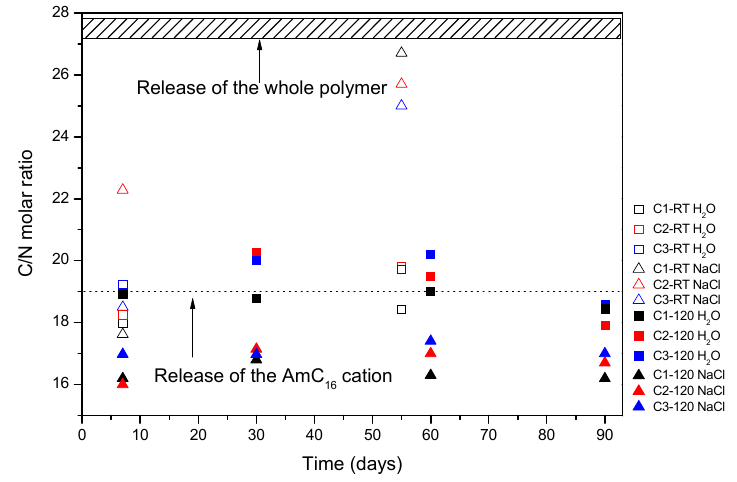
Figure 4. Evolution of the C/N molar ratio, determined from the TOC/ total nitrogen (TN) studies, after immersion in ultra ‐ pure water and NaCl 1 M for different time periods of uncured C1 ‐ RT, C2 ‐ RT, C3 ‐ RT polymeric coatings and cured C1 ‐ 120, C2 ‐ 120, C3 ‐ 120 polymeric coatings.